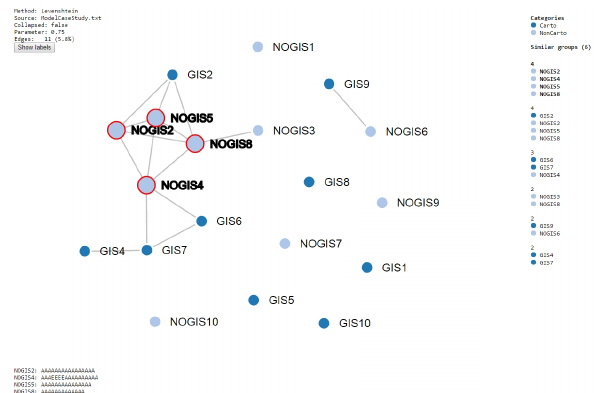
Figure 12. ScanGraph output showing two cliques based on parameter (cid:1868) (cid:3404) 0.75 .